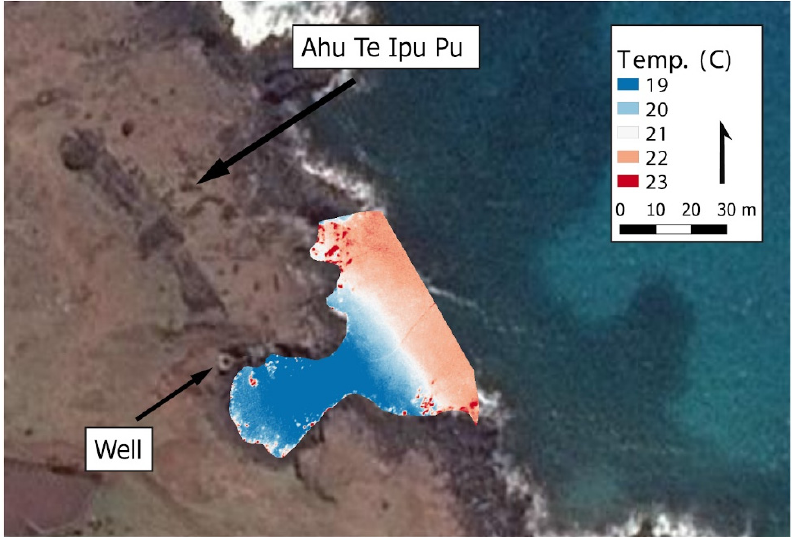
Figure 4. Thermal image of submarine groundwater discharge at Te Ipu Pu, showing the locations of the ahu (ceremonial statue platform) and a modern well that is being used to pump groundwater out for